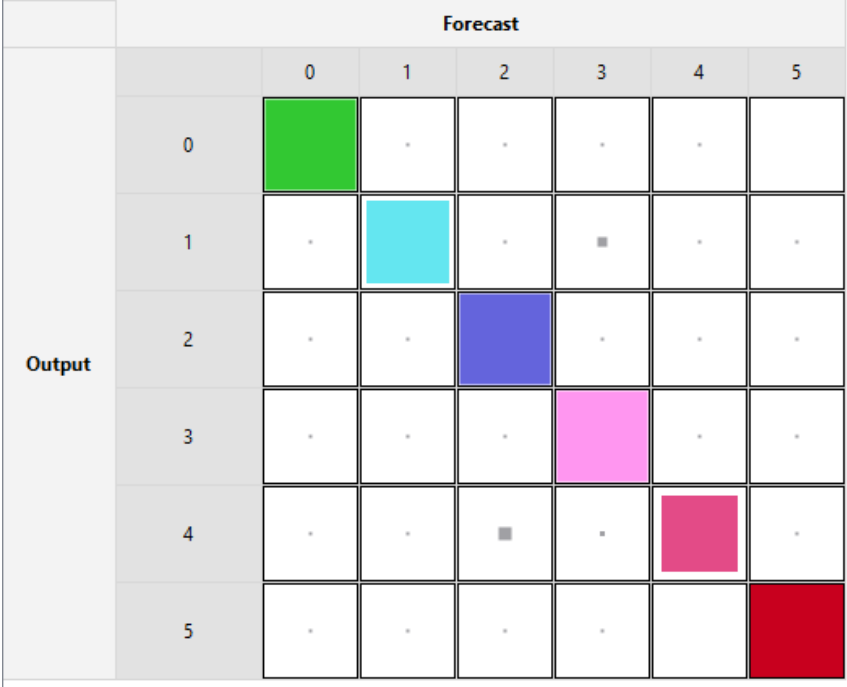
Figure 10. Testing Accuracy for Vehicle Activity Recognition using KNN.